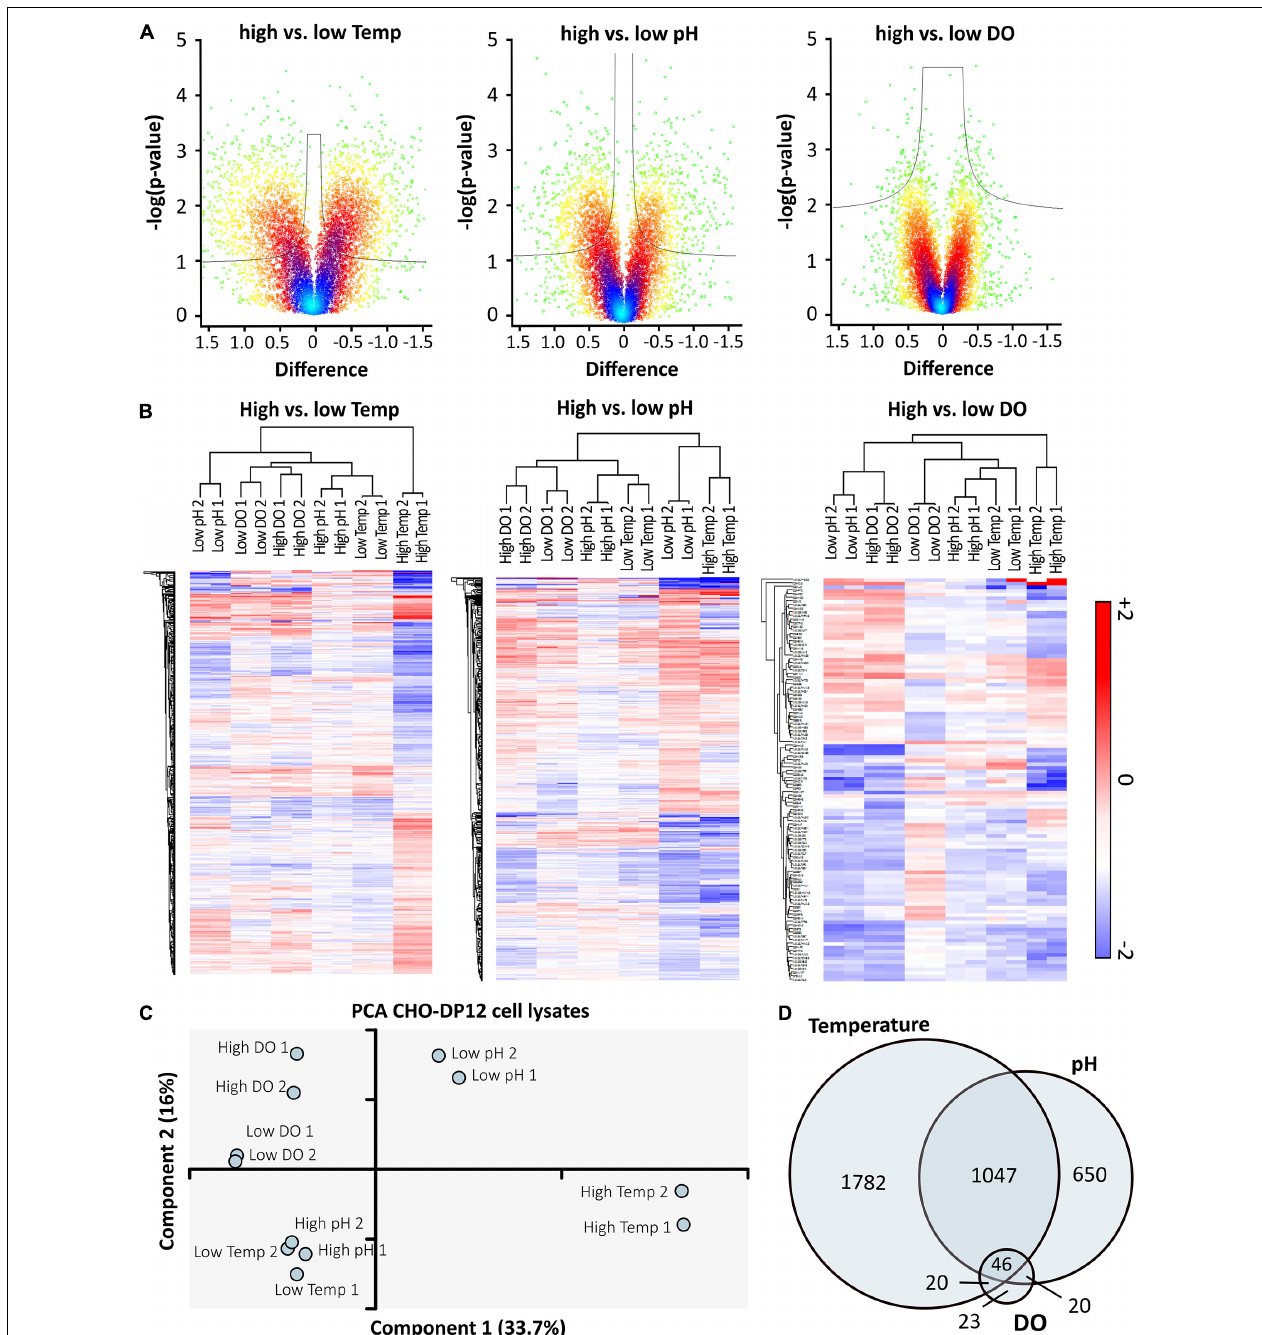
FIGURE 4 | High vs. low cell culture conditions were compared using volcano plots (A) with cut-off curves indicating significance determined by a two-sided t -test with a permutation-based FDR of 0.05 and S0 of 0.03 ( n = 2). Color of the plot indicates spatial density. Significantly regulated proteins were used for hierarchical clustering (B) based on Euclidian distance. Red indicates upregulation, blue shows downregulation of proteins compared to standard conditions. The PCA (C) indicates relationships between prepared technical replicates ( n = 2) and applied processing conditions. The Venn-diagram (D) shows the overlap of significantly regulated proteins after shifting temperature, pH, or DO concentration. Data was analyzed using Perseus software (version 1.6.6).